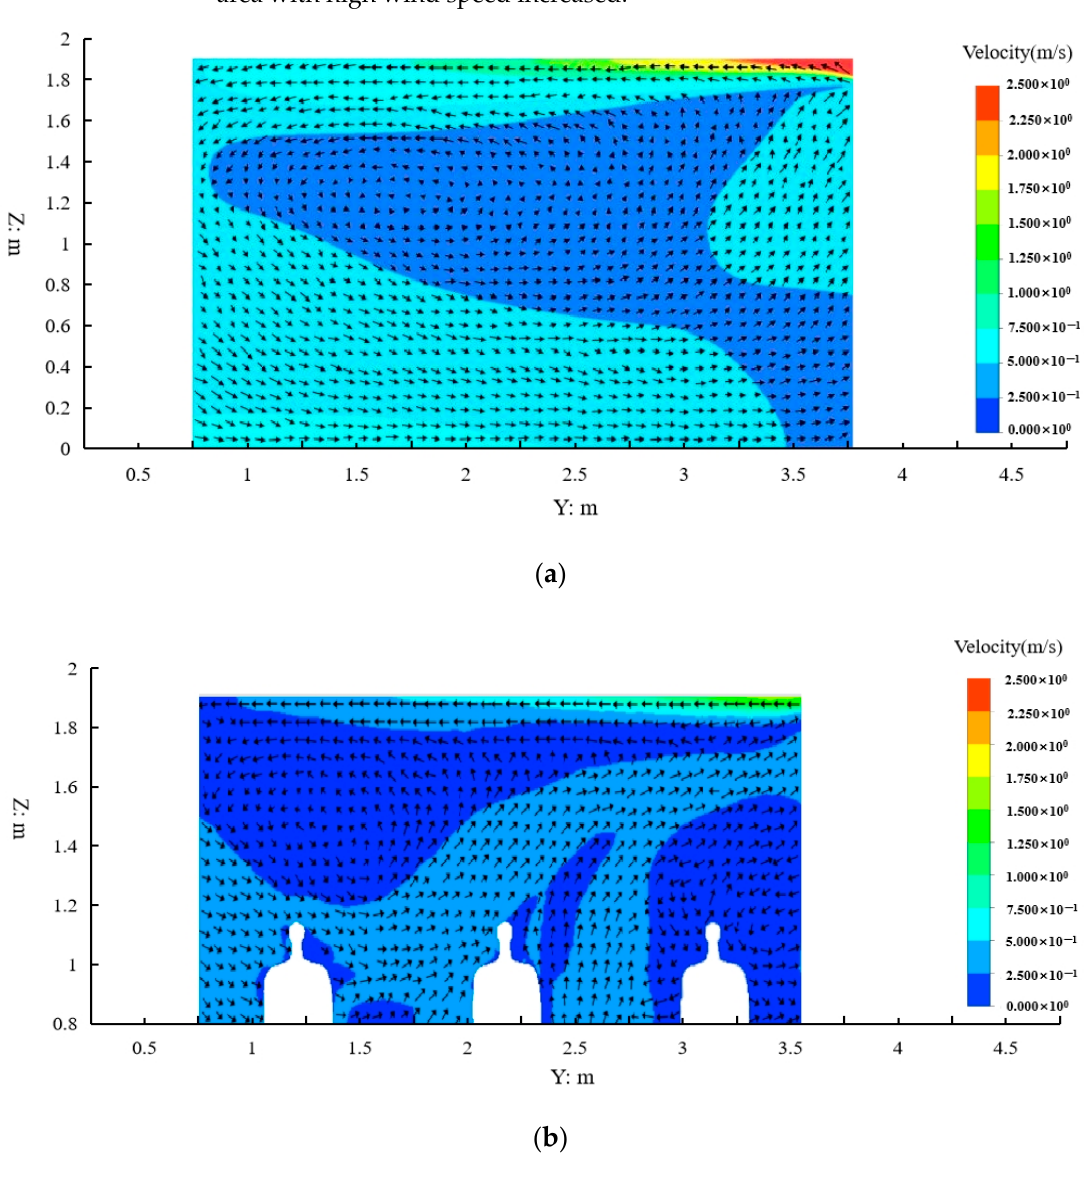
Figure 20. Vector diagrams of wind speed distribution in manned/unmanned shelters. ( a ) Vector diagram of surface 4 in the unmanned shelter. ( b ) Vector diagram of surface 4 in a manned shelter.